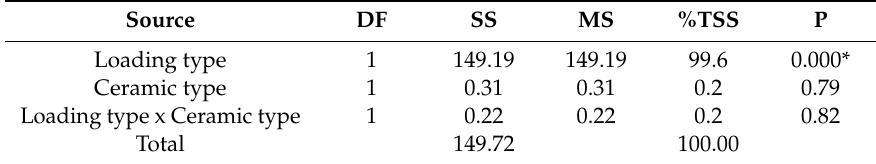
Table 3. Summary of the ANOVA showing the statistical results of the maximum stresses of di ff erent loading and ceramic types concerning the primary molar.